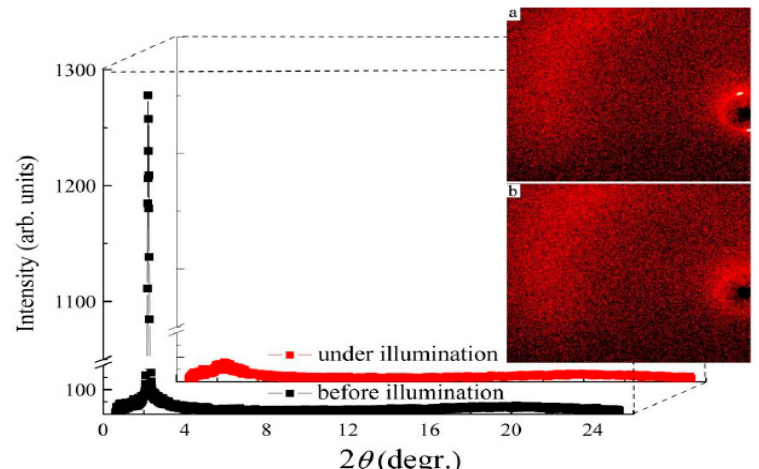
Figure 21. The XRD of compound 20d in the SmC A P A phase at T = 100 °C before (black line) and under the irradiation of light with λ = 365 nm. The inset represents 2D XRD ( a ) before, and ( b ) under the irradiation of light with λ = 365 nm. (Reproduced with permission from ref. [110], copyright of